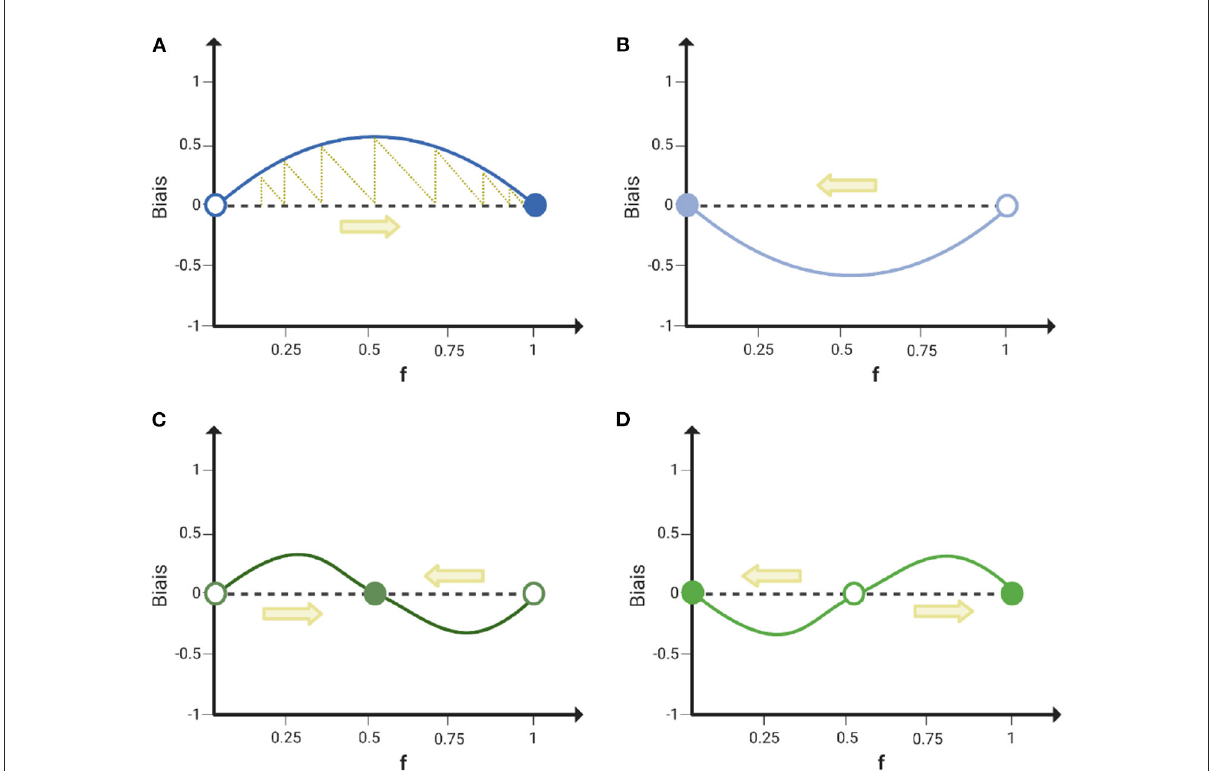
FIGURE4 Four qualitatively different frequency-dependent aggregation biases correspond to distinct evolutionary stable states. Schematic representation of the four simplest classes of bias that can be obtained in a binary mix. The evolutionary dynamics of a binary mix composition ( f ) over many rounds of co-aggregation is represented by the yellow arrows. Stable equilibria are represented as filled circles and unstable ones as empty circles. The yellow dotted line in (A) illustrates the construction of the evolutionary trajectory: Each round starts with a mix composition equal to the aggregates composition at the end of the previous round, that is obtained by adding to the initial composition the aggregation bias. The four classes of bias give rise to different evolutionary stable solutions: fixation of the focal type (A) exclusion of the focal type (B) , coexistence of both types (C) and bistability (D)